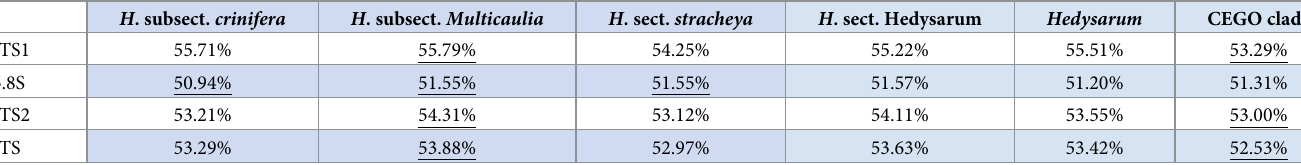
Table 1. The GC content of three ITS regions among clades.